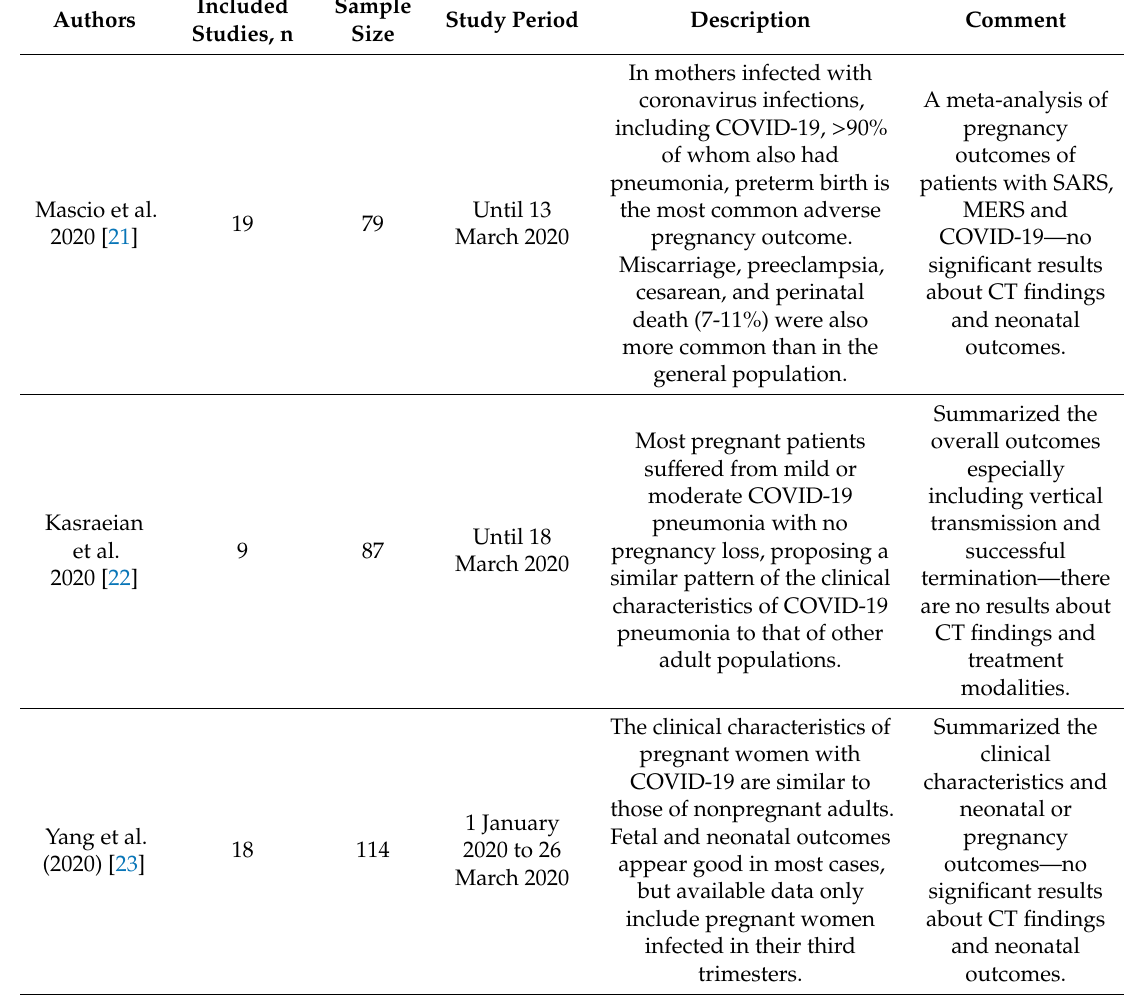
Table 1. Main characteristics and findings of the previous published systematic reviews /